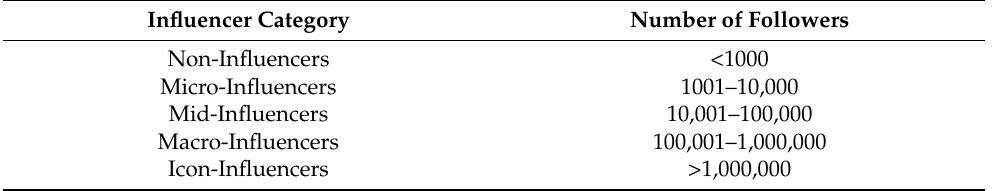
Table 1. Number of followers